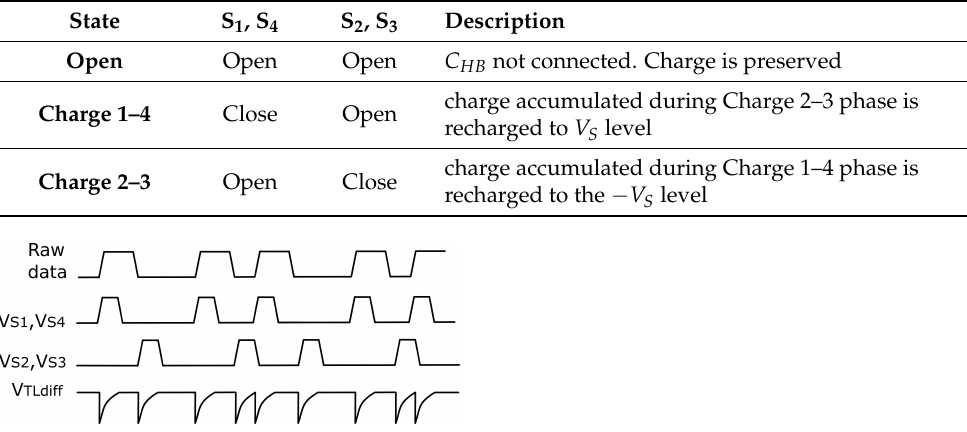
Figure 4. Example of transmission in H-Bridge TX topology.